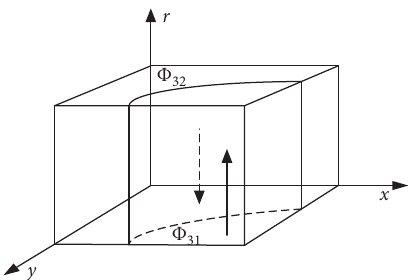
Figure 7: Dynamic evolution of owners’ decision